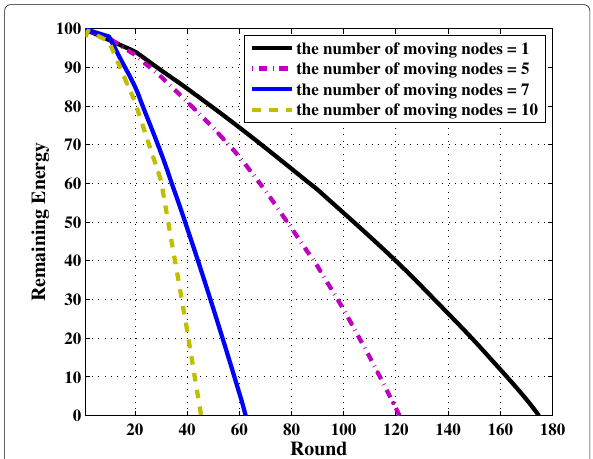
Fig. 6 The relation between remaining energy and the number of rounds